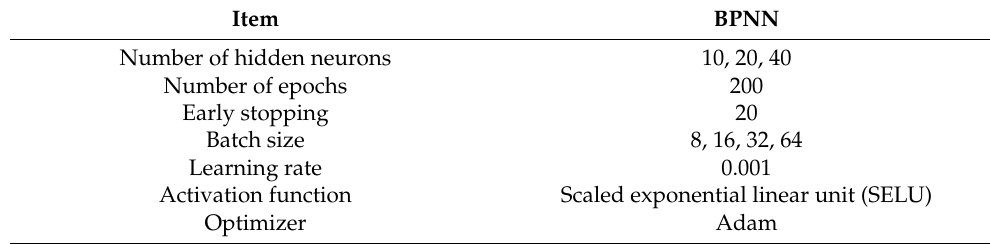
Table 2. Parameter setting of the BPNN model. Item BPNN